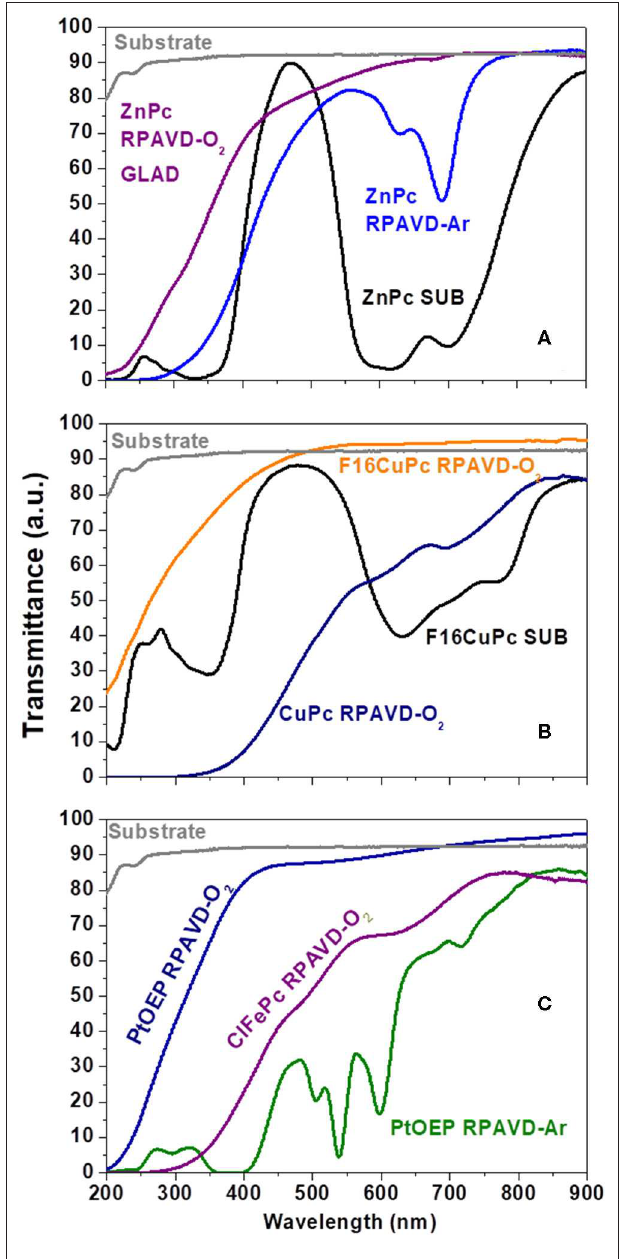
FIGURE 2 | (A-C) UV-Vis Transmittance spectra comparing samples prepared under different experimental conditions as labeled.